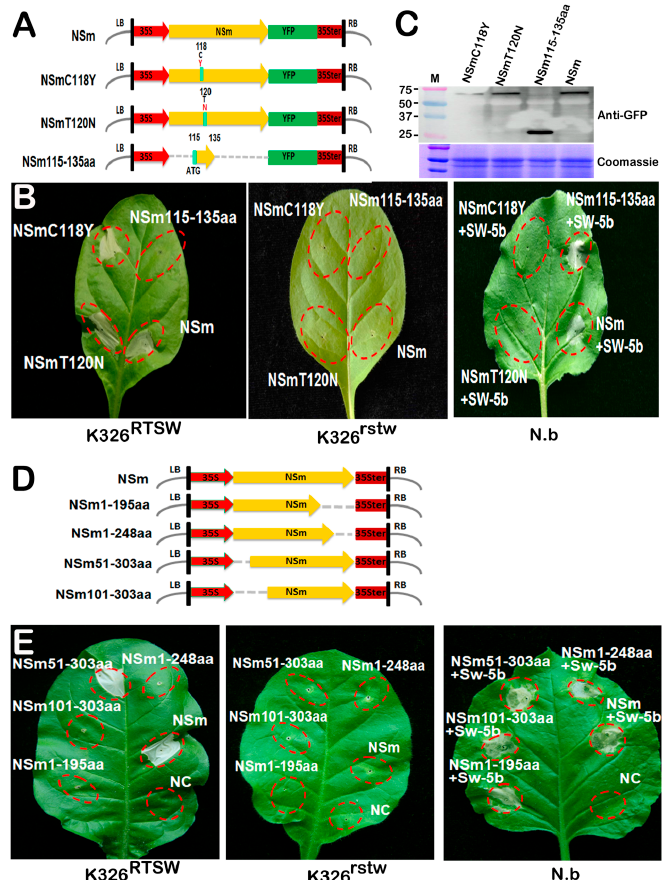
Figure 5. Effect of key amino acids and a conserved motif of NSm on RTSW-mediated induction of HR. ( A ) Schematic representation of NSm-YFP fusion constructs. NSm variants carrying aa